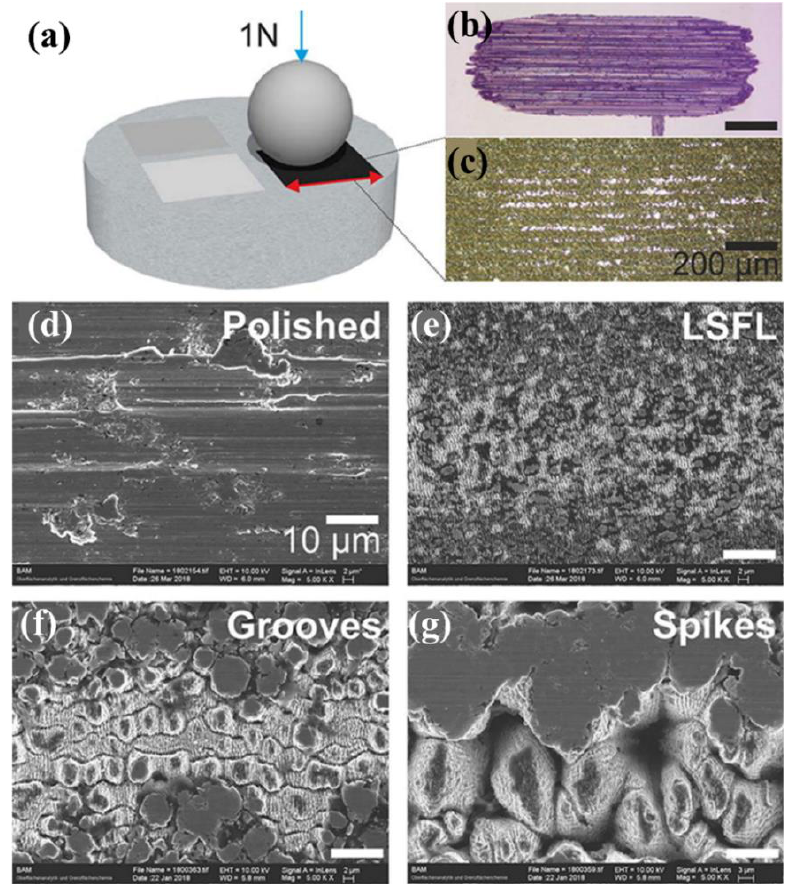
Figure 11. Ref. [110] Tribological performance of the samples after irradiation. ( a ) Sketch of the tribology setup using a steel ball of 100 Cr6 on the surface of the Ti6Al4V alloy sample. The final wear track achieved after 1000 sliding cycles is shown in ( b ) for the free surface and in ( c ) for a Spike-covered area as optical micrographs. SEM micrographs of the wear track on the different areas are shown in ( d ) for the initially polished surface, ( e ) LSFL, ( f ) Grooves, and ( g ) Spikes.